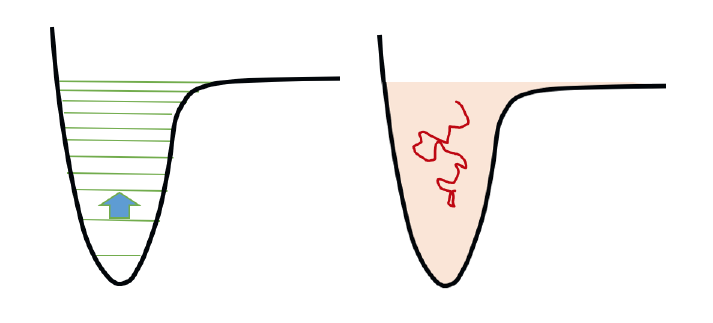
Figure 3. Symbolic representation of the state-to-state chemical kinetics and its equivalent in the continuum. On the left, the arrow represents a one-quantum collisional transition between two consecutive levels. On the right: the level manifold is approximated by a continuum of energy, the kinetics is sampled by Brownian motions, the energy transport is drift-diffusive. Drawing adapted from